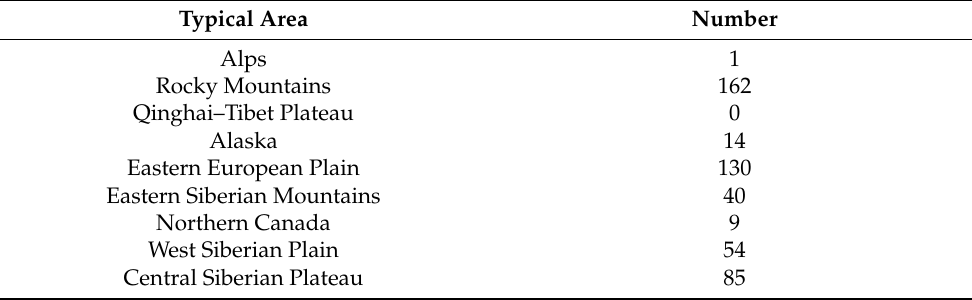
Table 1. Number of ground observation sites in the different typical areas. Typical Area Number Alps 1 Rocky Mountains 162 Qinghai–Tibet Plateau 0 Alaska 14 Eastern European Plain 130 Eastern Siberian Mountains 40 Northern Canada 9 West Siberian Plain 54 Central Siberian Plateau